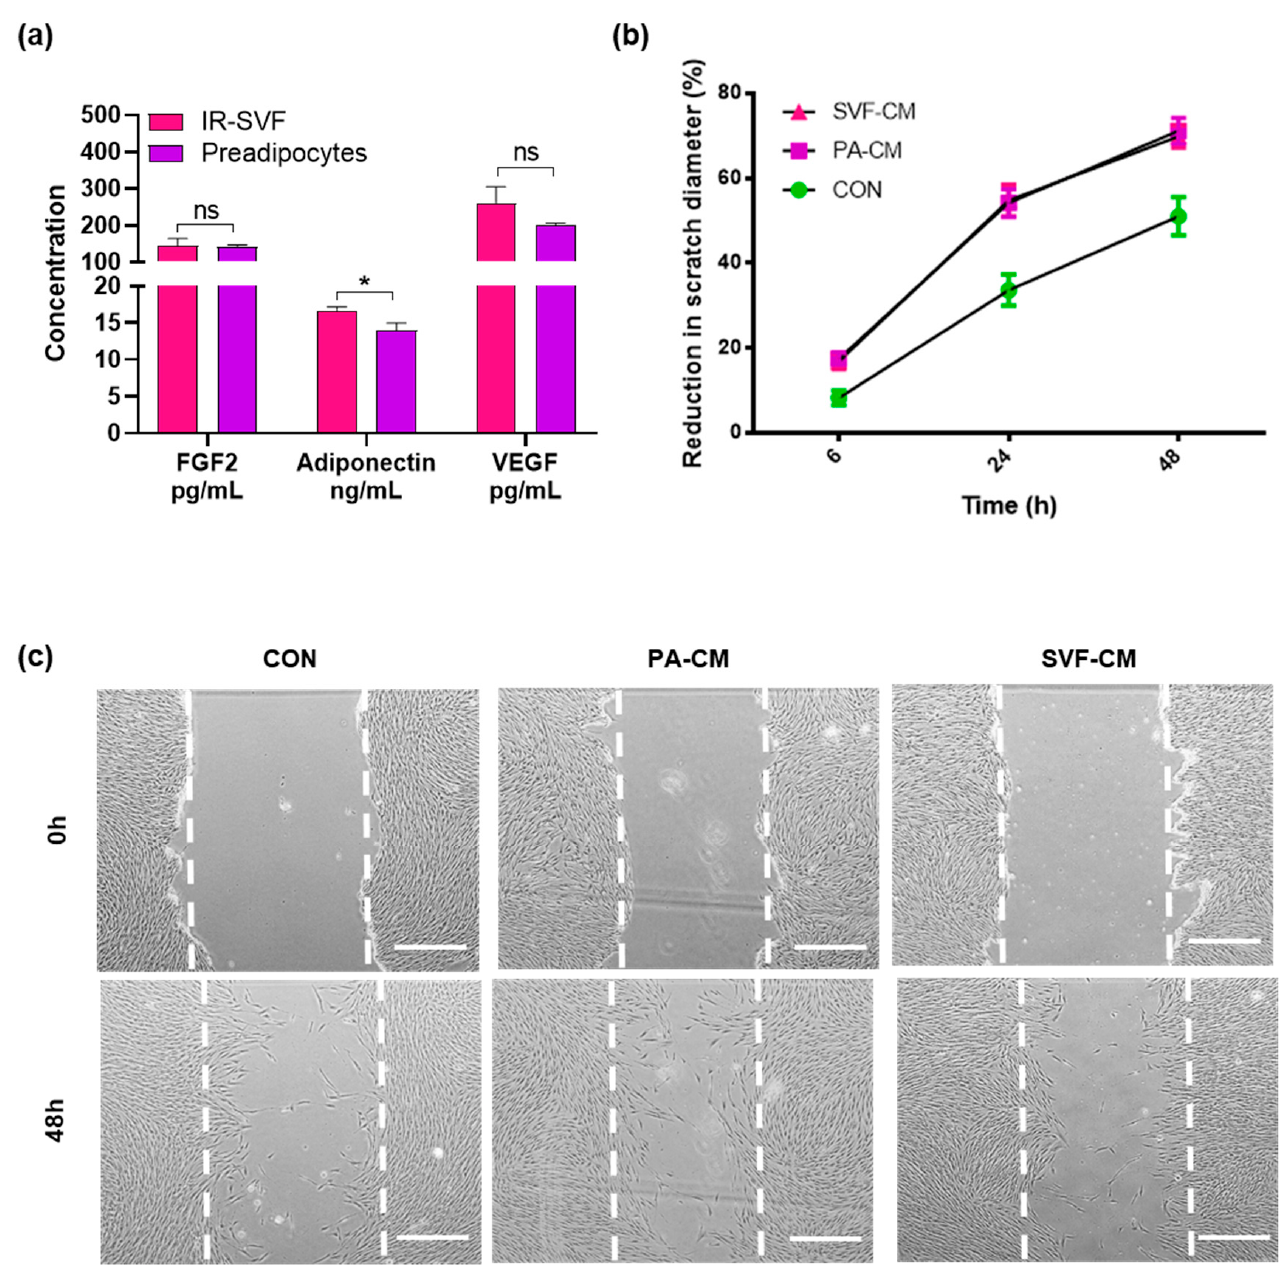
Figure 3. CM from IR-SVF promotes DF scratch wound healing to a comparable degree as CM from commercial preadipocytes. IR-SVF and commercial preadipocytes were cultured in serum-free media for 24 h and CM collected. ( a ) Expression of chemokines FGF2, adiponectin and VEGF was assessed using ELISA. ( b ) The ability of CM to promote in vitro wound healing of DF monolayers was monitored for up to 48 h. ( c ) Representative images captured at ×40 magnification, scale bars = 500 um, white dotted line is wound edge. n = 4; ns = not significant; * p < 0.05. CM, conditioned media; DF, dermal fibroblast; ELISA, enzyme-linked immunosorbent assay; FGF2, fibroblast growth factor 2; IR-SVF, stromal vascular fraction from irradiated tissue; VEGF, vascular endothelial growth fac- tor.